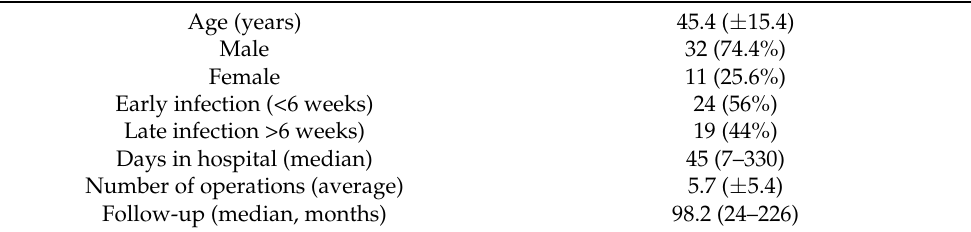
Table 1. Clinical characteristics of 43 patients with implant-associated infections of the pelvis and the